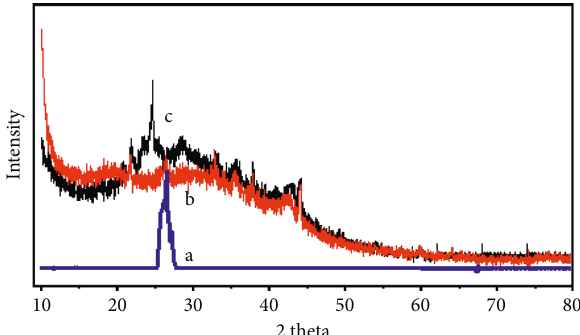
Figure 6: X-ray diffraction patterns of (a) graphite powder, (b) GO powder, and (c) rGO